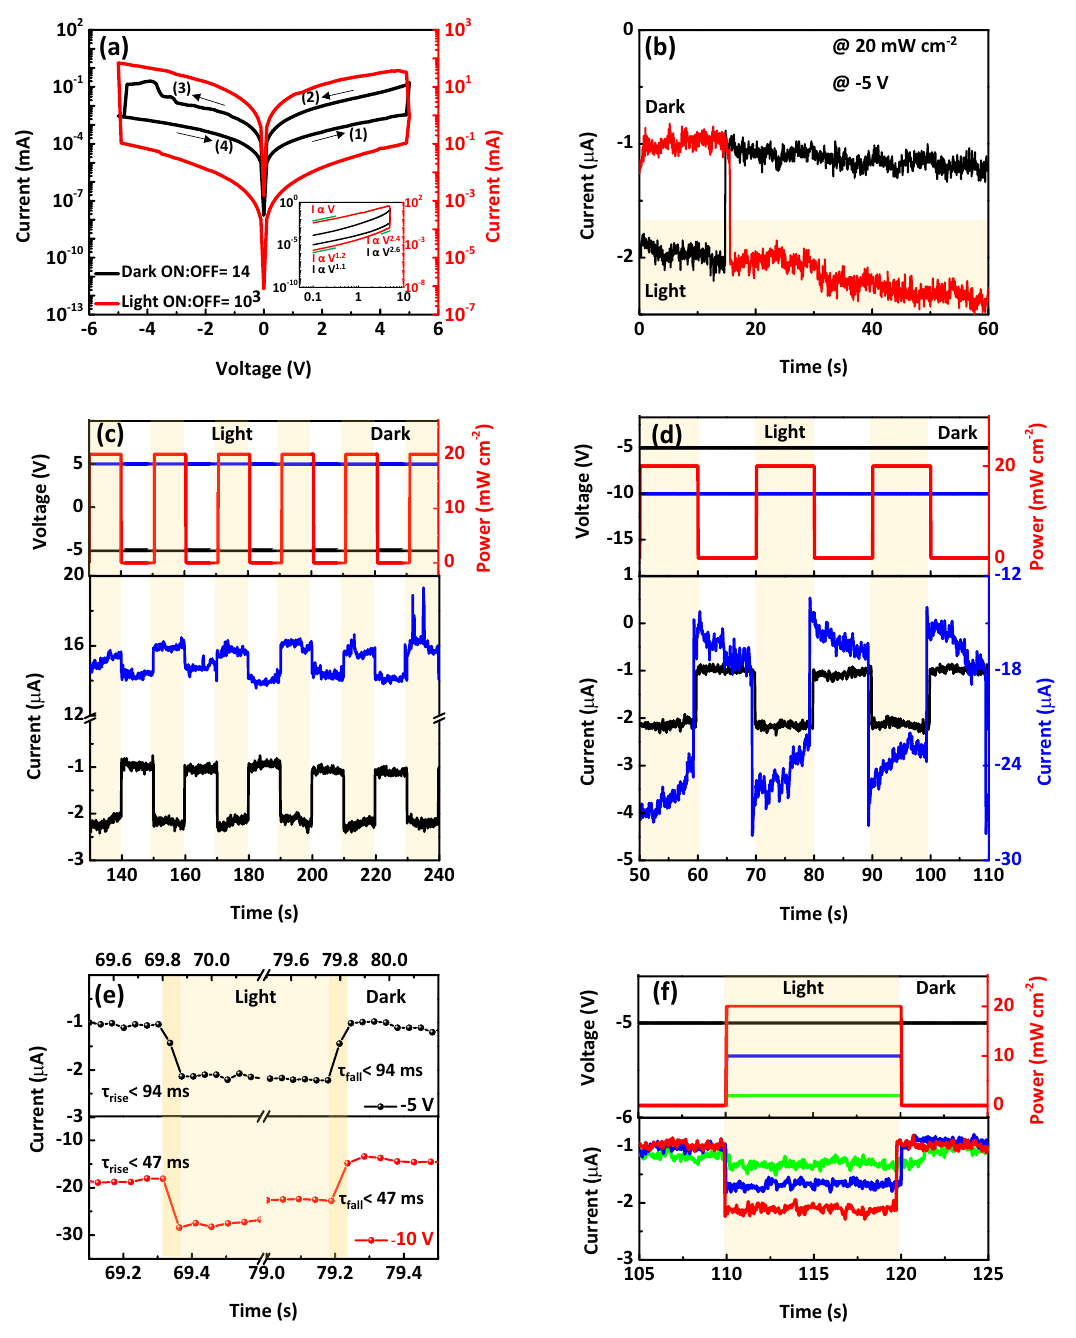
Figure 2. ( a ) I–V curves of sweeps in dark (black line) and light (red line) states for memristor devices based MFC composite. An excellent enhancement of the memristive performance of device was observed under light illumination. Inset: Log–log plot of sweeps from ( a ) which show an Ohmic I–V behavior in the low bias region of both set and reset states. By increasing the bias, the SCLC transport remains the dominant mechanism of device. ( b ) Time evolution of current in − 5 V and the light illumination of 20 mW cm −2 , denoting the states of programming and erasing with and without illumination, respectively. ( c ) the pulse-switching characteristics of the MFC-based optical memristor under a negative and positive bias. d) The photo-response dynamics of the MFC-based optical memristor under − 5 and − 10 V bias voltages with a power intensity of 20 mW cm −2 in three operation cycles. ( e ) The corresponding rise and fall time under − 5 and − 10 V bias voltages. ( f ) Current–Time curve of photo-response as a function of light intensity at – 5 V bias in a single operation